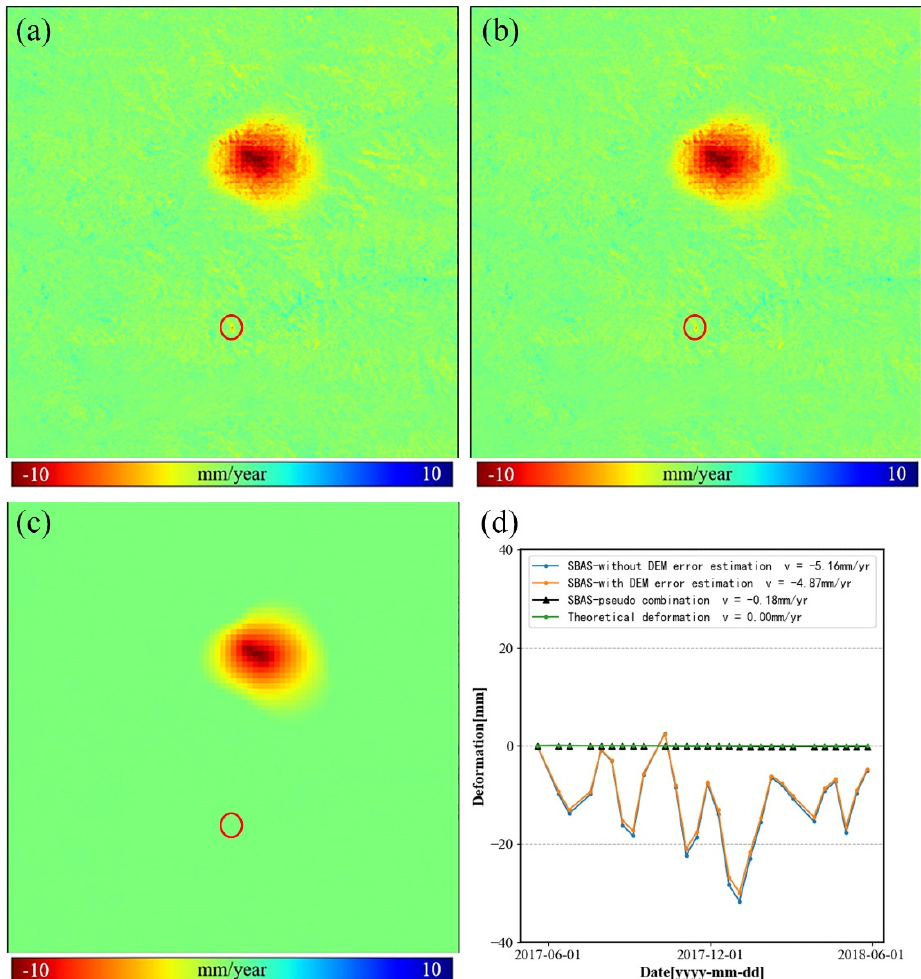
Figure 5. The deformation estimations calculated by different algorithms. ( a ) Deformation field calculated by SBAS (without DEM error estimation); ( b ) deformation field calculated by SBAS (with DEM error estimation); ( c ) deformation field calculated by pseudo-combination SBAS; and ( d ) the deformation time series calculated by different algorithms.